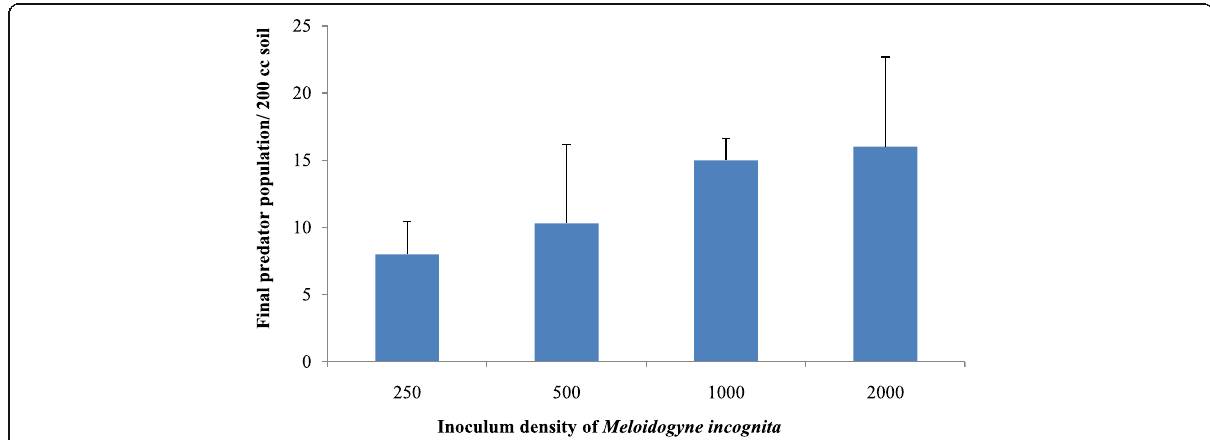
Fig. 2 Final population of Fictor composticola at different inoculum levels of Meloidogyne